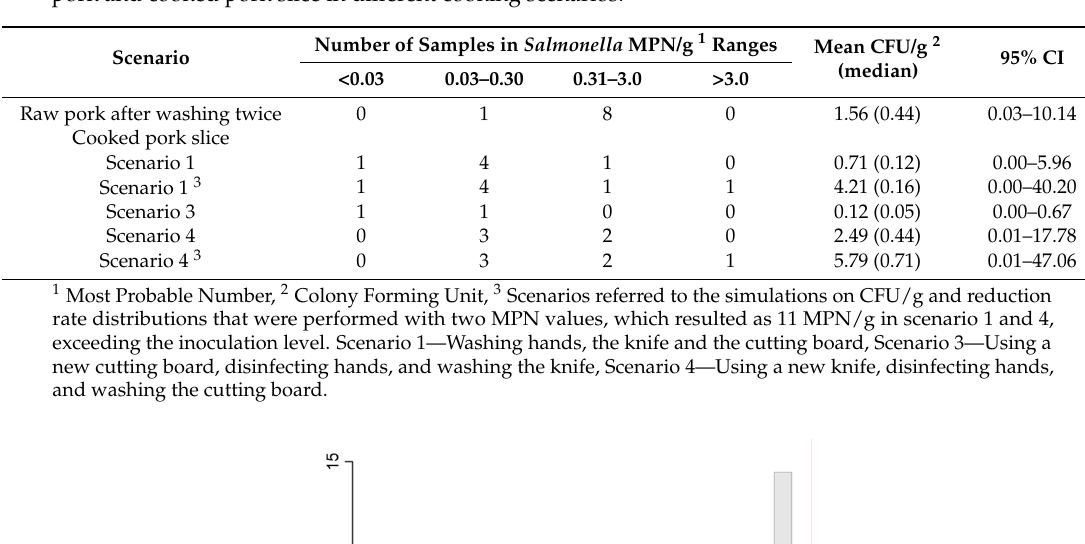
Table 3. Frequencies of MPN/g results categorized in MPN ranges and integrated Salmonella concentration distributions as mean, median, and confidence interval of CFU/g for washed raw pork and cooked pork slice in different cooking scenarios.